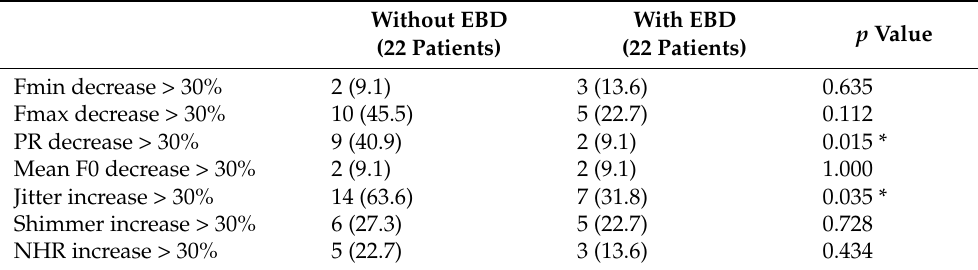
Table 3. Six-week postoperative objective voice analysis in Group B with or without EBD.